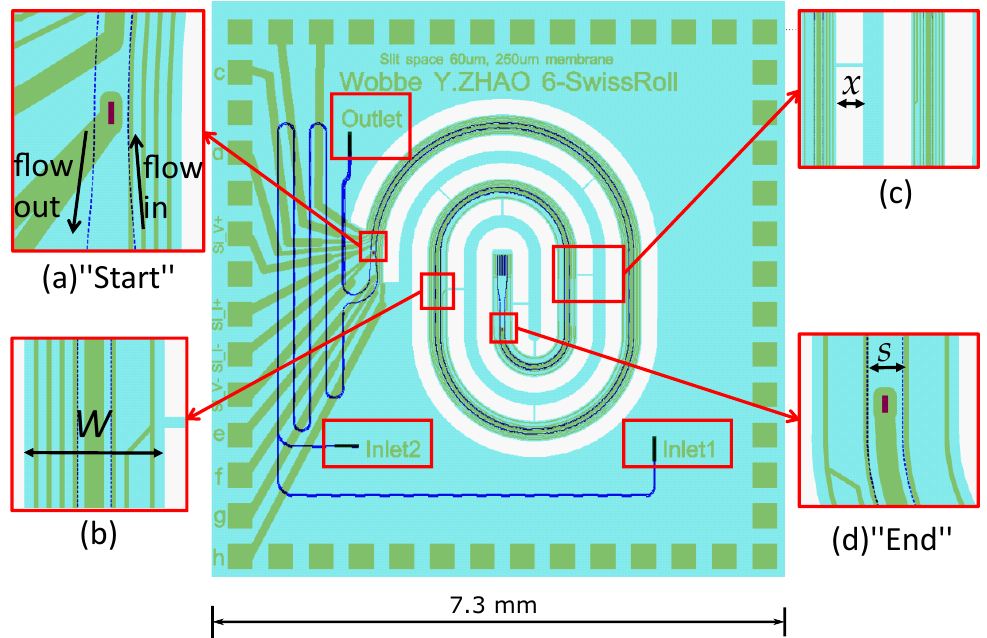
Figure 8. The demonstrator chip mask designs show that the swissroll-shaped microchannels and the embedded microheater are suspended. Metal wires (green color) are placed on top of the SiRN microchannels (blue color). The close-up views in ( a , d ) show two electrical contacts for the silicon microheater. Two parallel rows of slits form two separated microchannels and one silicon microheater is embedded in between. The close-up view in ( b ) shows the SiRN membrane width of W = 250µm, in ( c ) shows the release windows of width of x = 200µm, and in ( d ) shows the row spacing of S =